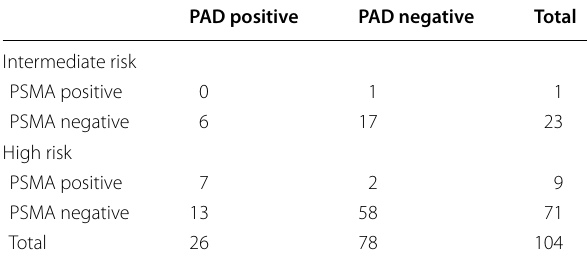
Table 4 Lymph node status by PSMA and by histology report (PAD) for intermediate and high risk